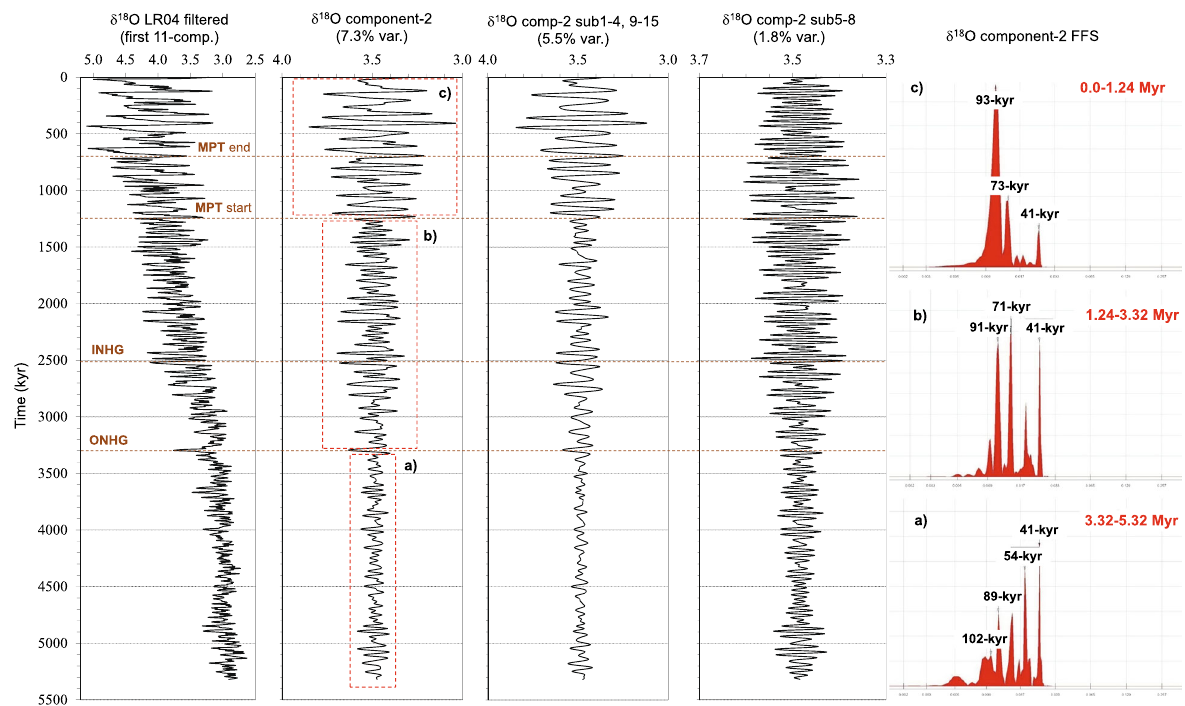
Fig. 3 Time-series panel of δ 18 O component-2 and its subcomponents and Fourier frequency spectrum of comp-2 for three time intervals a , b and c , highlighted by red-labeled boxes. Note the evident increase in comp-2 amplitude after the ONHG and MPT, and the transition in periodicity from a obliquity to c eccentricity with a gradual upwards strengthening of the short eccentricity power. Interestingly, the amplitudes of the eccentricity in comp-2 subcomp-1-4, 9-15 are increasing, whereas the amplitude of the obliquity in comp-2 subcomp-5-8 is decreasing after the MPT. x -axis scale variable ( ‰ ). The y -axis scale of the frequency spectrum increases upwards. Time scale in